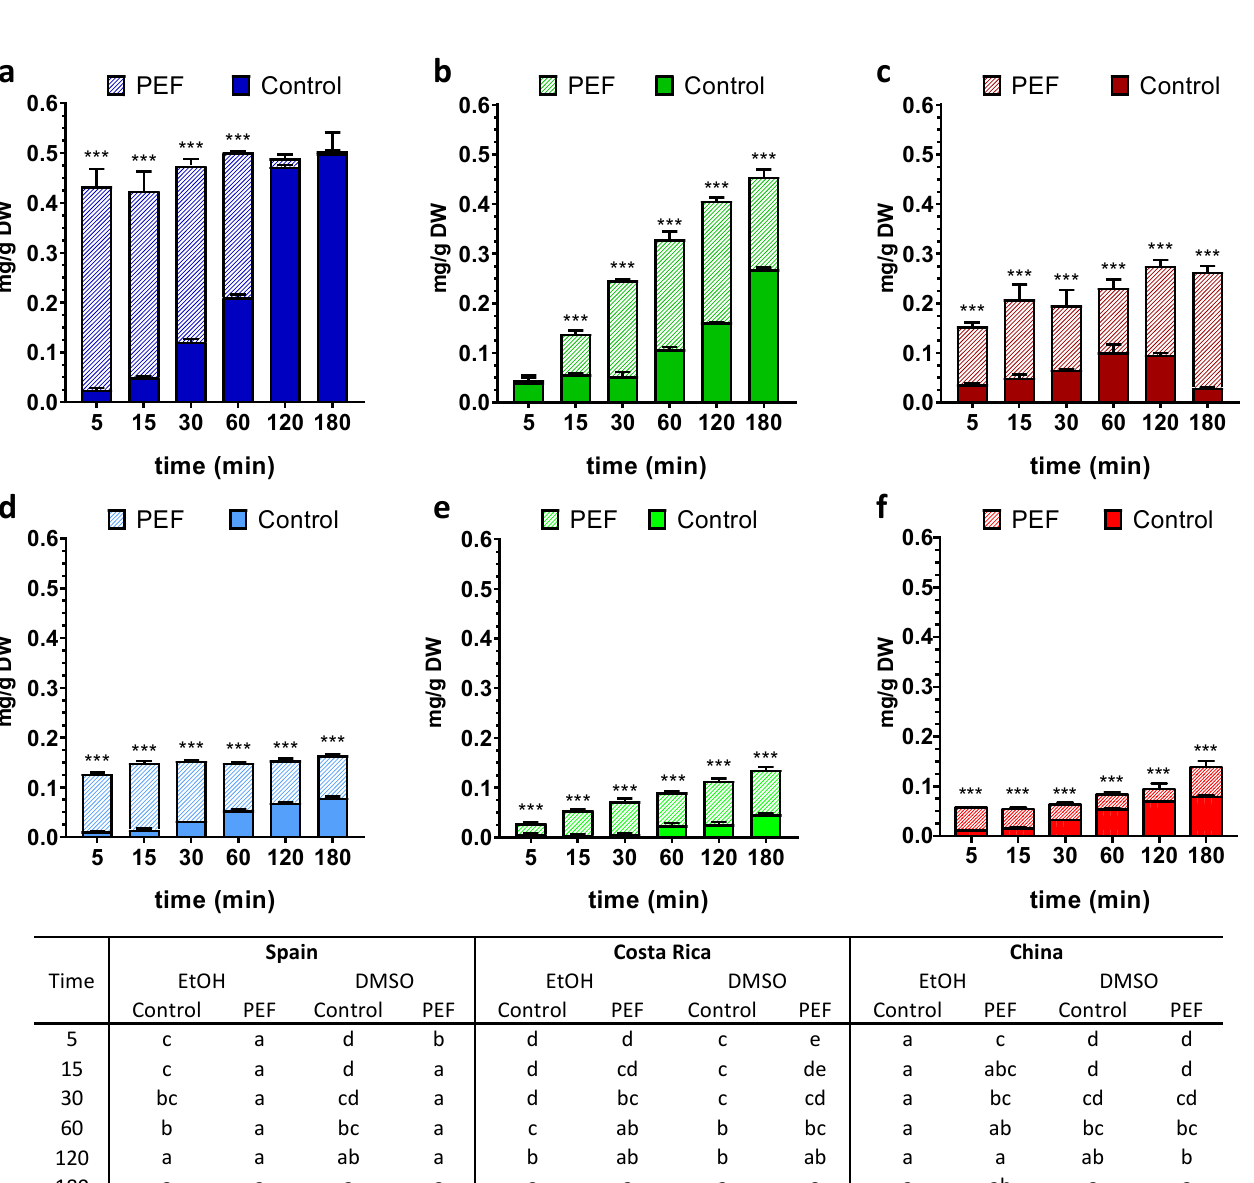
Figure 2. Total carotenoid content of Spirulina extracts with PEF treatment or without PEF treatment (Control) for ethanol:water ( a – c ) and DMSO:water ( d – f ) solvent from Spirulina cultivated in different geographical regions (blue: Spain, green: Costa Rica, red: China). Statistical differences related to the PEF treatment are represented by asterisks (*). Statistical differences related to the extraction time are represented by different lower-case letters in the table. *** = p < 0.001.